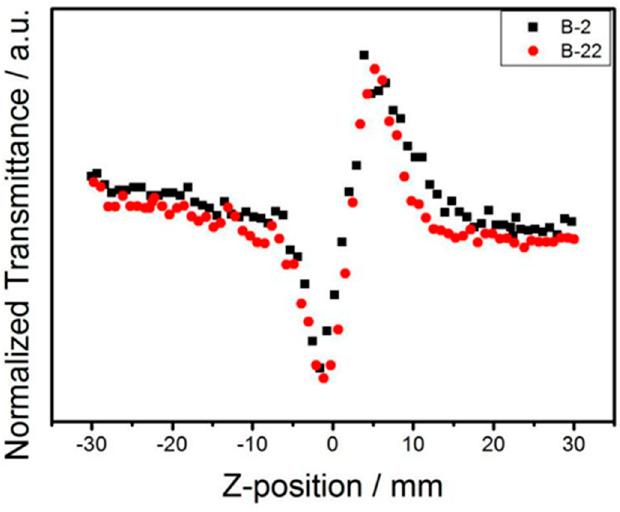
Figure 6. Regularized locked ori fi ce Z − scan traces of the compounds.